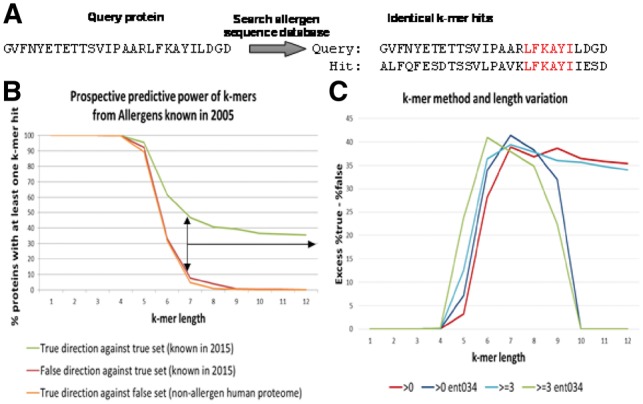
Prediction of protein sequence similarity towards protein allergens by the k-mer method. Screening for similarity between a query protein sequence and a sequence in the allergen database is based on identical k-mer hits (A). Evaluation of an appropriate k-mer length based on the predictive power of different k-mer lengths by using the UniProt database of known allergens from 2005 to predict all allergens known in 2015 (B). Differences in the excess of percent true minus false positives depending on the k-mer length and entropy degree (ent034 = entropy bit score > 0.34) (C)